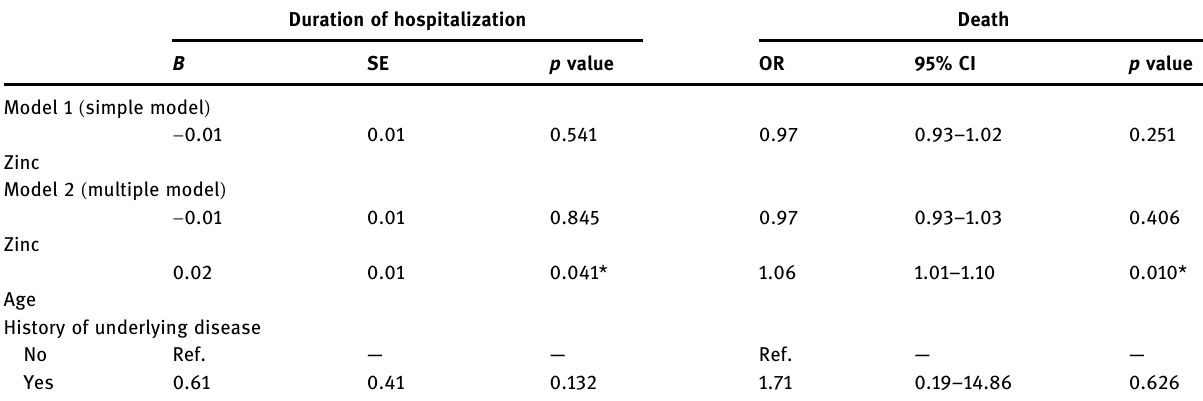
Table 3: Factors associated with duration of hospitalization and survival Duration of